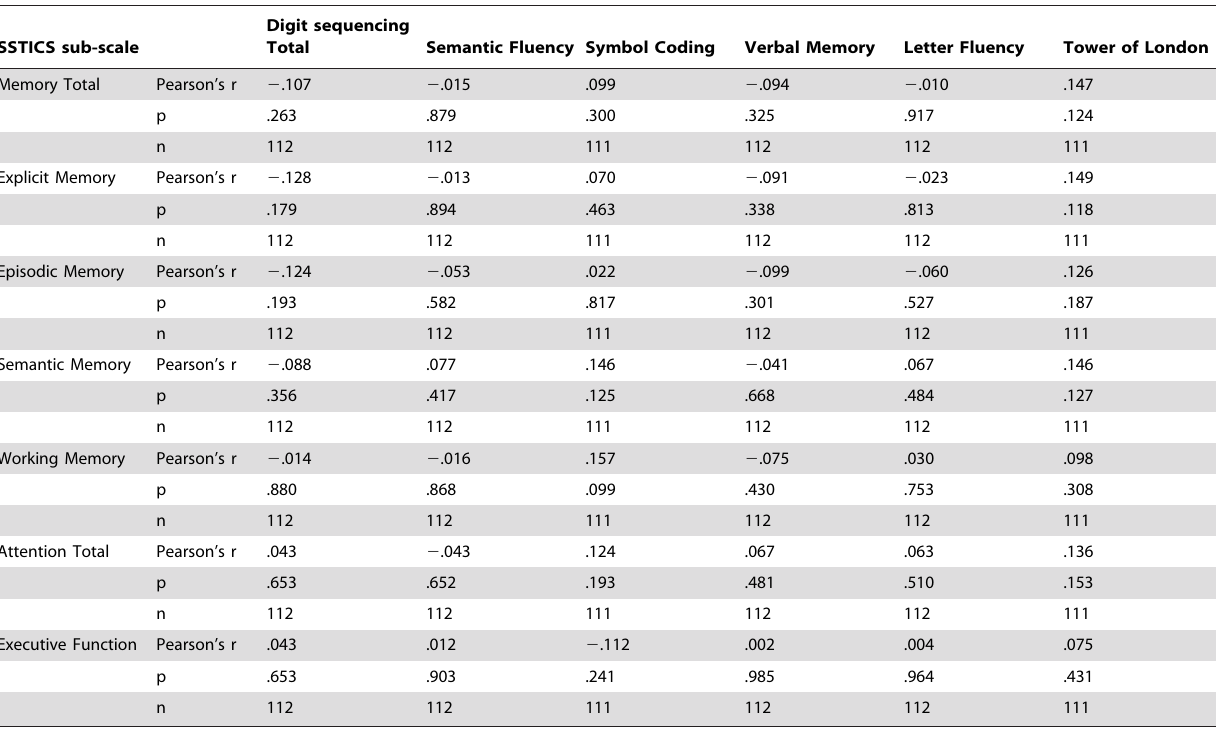
Table 2. Correlations between STICSS and BACS subscale scores in the patient